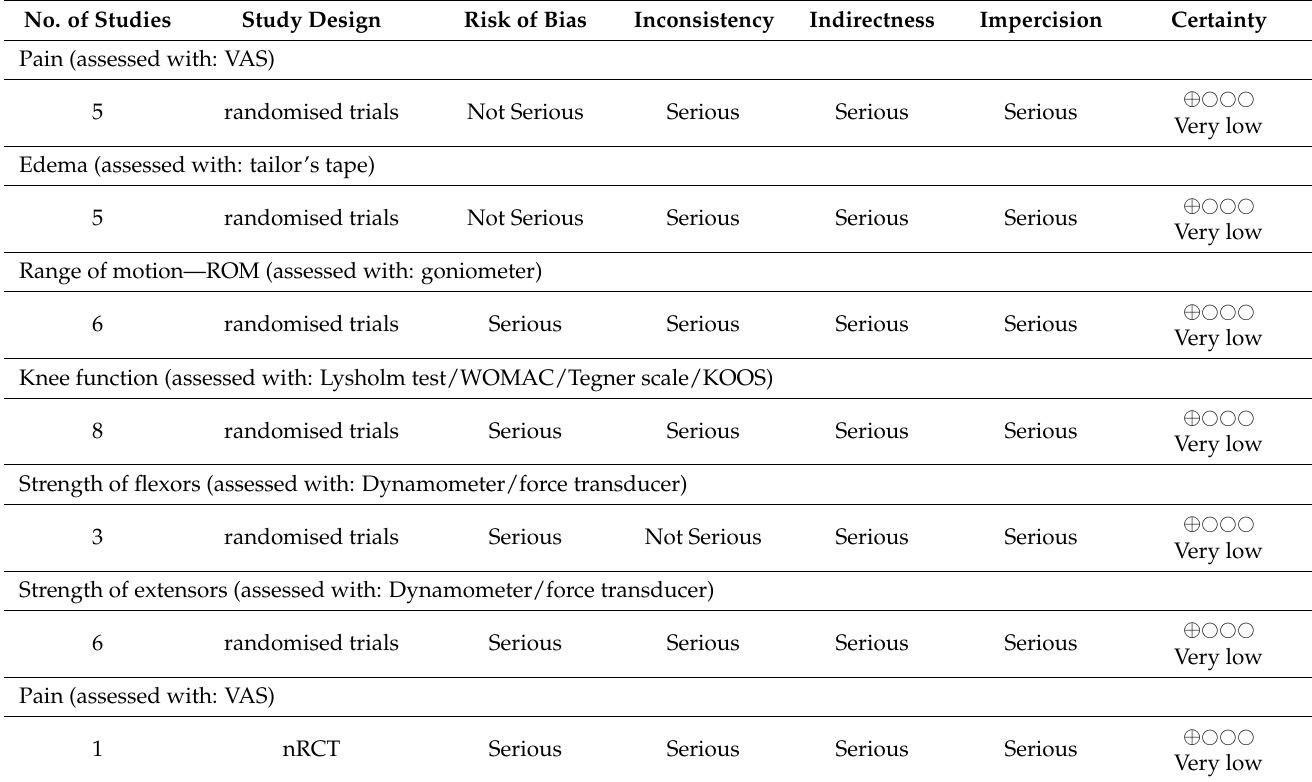
Table 3. Certainty of evidence